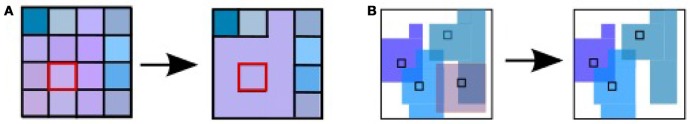
Region growing and selection algorithm. (A) Region growing, left: each voxel (colored squares) serves as center for a cluster, right: example of a growing region (purple), only adjacent voxels that fulfill the fusion criteria are added to the growing cluster. (B) Region selection. Small regions (pink) with centers overlapping with larger regions (green) get deleted (from left to right) in a iterative manner. Remaining regions can still overlap as long as their centers do not cover other regions. This illustration is in 2D for simplicity, the algorithm used for fMRI data acts in 3D following the same rules.